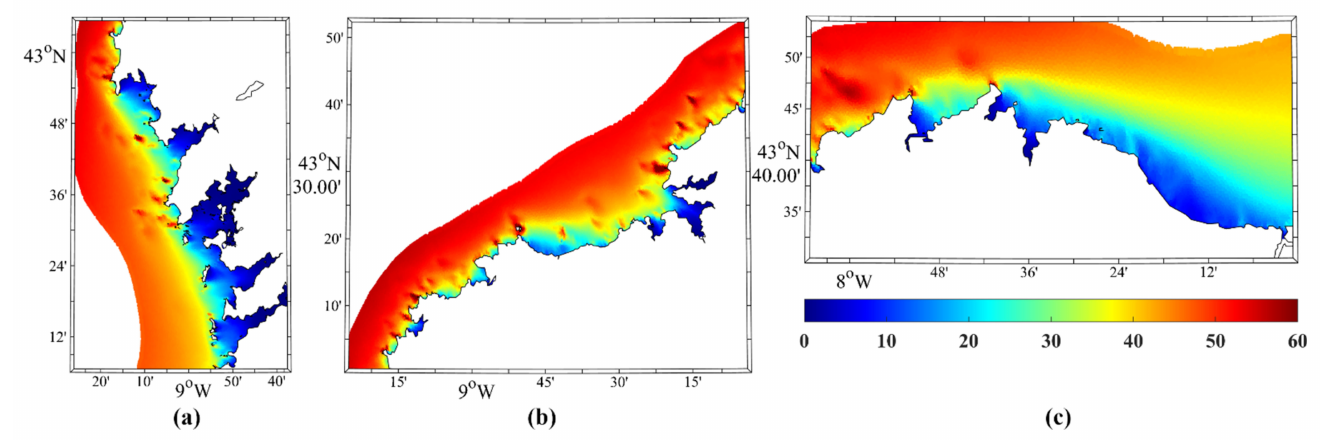
Figure 3. WP resource for ( a ) West Coast, ( b ) Northwest Coast, and ( c ) North Coast from 2014 to